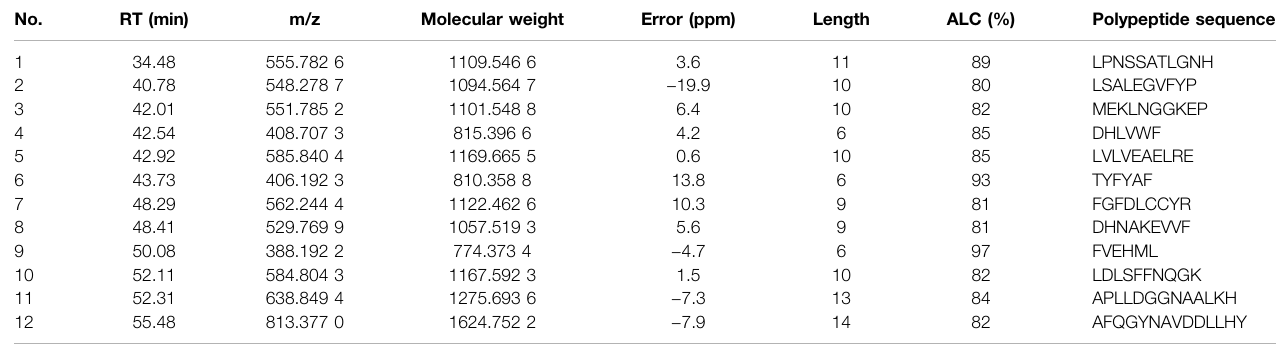
TABLE 1 | Identi fi ed peptides in pilose antler.